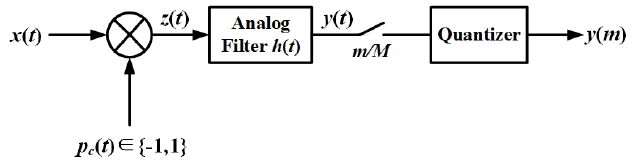
Figure 2. The basic random demodulator (RD) architecture of analog-to-information converter (AIC). Modulation This stage uses a modulator whose input signal x ( t ) is multiplied by a continuous time sequence of pseudo random numbers p c ( t ) to obtain an output signal z ( t )